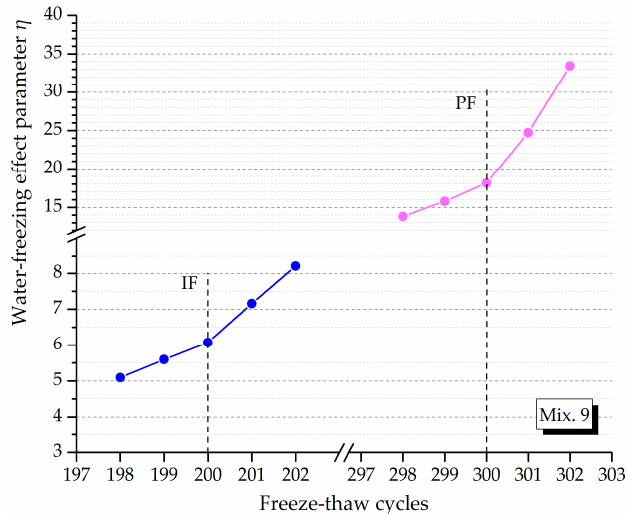
Figure 12. The surface appearance of typical ECC mixtures: ( a ) Mix. 6 after 25 cycles; ( b ) Mix. 4 after 175 cycles; ( c ) Mix. 9 after 200 cycles. Figure 11. The water-freezing e ff ect parameter η versus the freeze-thaw cycles. Figure 11. The water-freezing effect parameter η versus the freeze-thaw cycles.